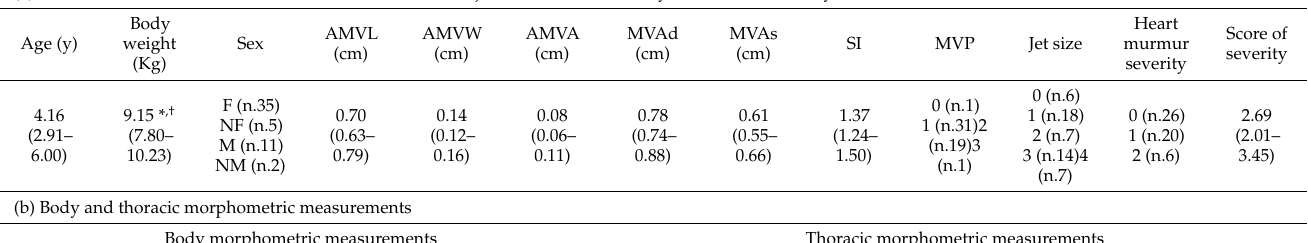
Table 2. Clinical data showing indexed mitral valve measurements, MVP, jet size, murmur severity, severity score, morphometric measurements, indexes, coat color type, and BCS of all the subjects included. (a) Clinical data, indexed mitral valve measurements, MVP, jet size, murmur severity, and score of